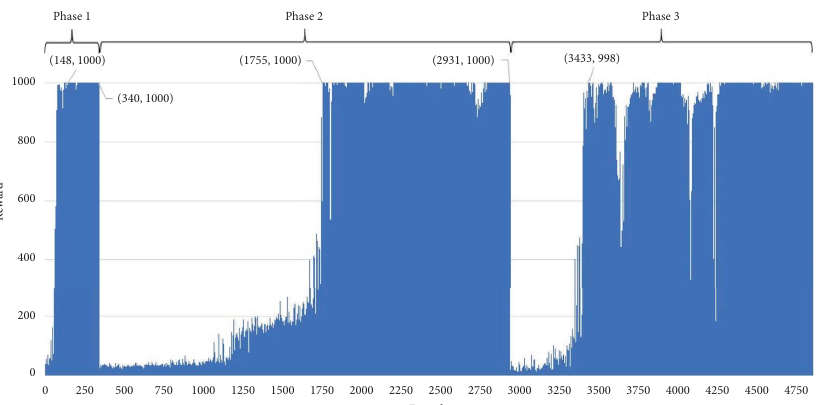
Figure 11: Consecutive 5000 training episodes of the scenario (100km/h, 400m). Te fuctuation curves are shown in 3 phases.